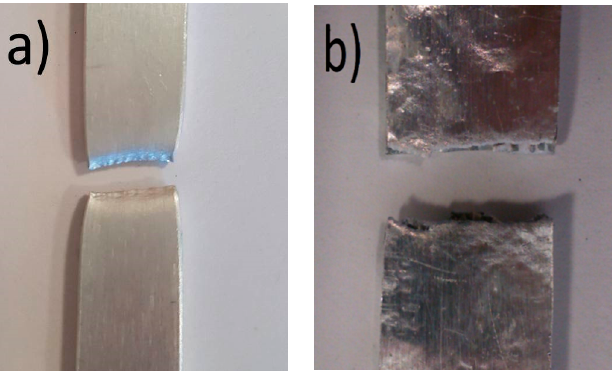
Figure 14. Fracture modes: ( a ) Al 1050; ( b ) CMFM specimen.